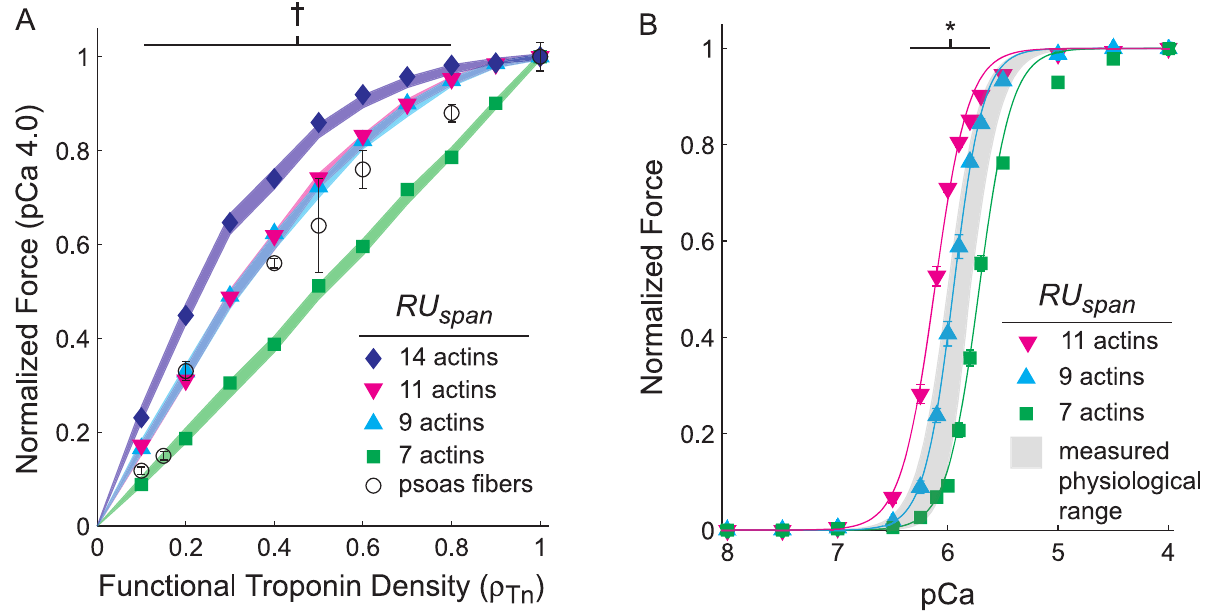
Figure 2. Regulatory unit activation span affects steady-state force production. Simulations where Ca 2 + activated thin filament distance ( RU span ) varied while co-varying the fraction of troponin complexes capable of binding Ca 2 + ( r Tn ) show maximal, steady-state force as a function of r Tn (A). Measurements from demembranated rabbit psoas muscle fibers ( # in panel A) show that maximal steady-state force increased with the fraction of troponin capable of binding Ca 2 + , replotted from Figure 4 of Regnier et al. [4]. RU span also affects the cooperative, steady-state force-pCa relationship (B). All values were normalized to the pCa 4.0 value within each simulation set and symbols represent mean 6 SE for measured and simulated data, where error bars lay within the symbol when not visible. These simulations combined all possible forms of cooperativity from sources TF3, XB2, or XB3, targeting r t,12 and/or r t,23 when applicable. Shaded underlays represent 95% confidence intervals for maximal force from 3- parameter Hill fits. { denotes where data from RU span values of 7 and 14 actins differed from RU span values of 9 and 11 actins ( p , 0.05 ). * denotes where data from all RU span values differed ( p , 0.05 ).